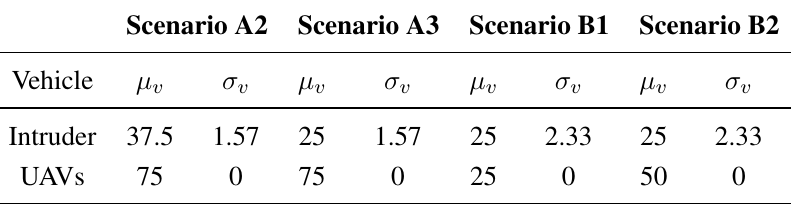
Table 2. Vehicle parameters for Scenarios A and B.